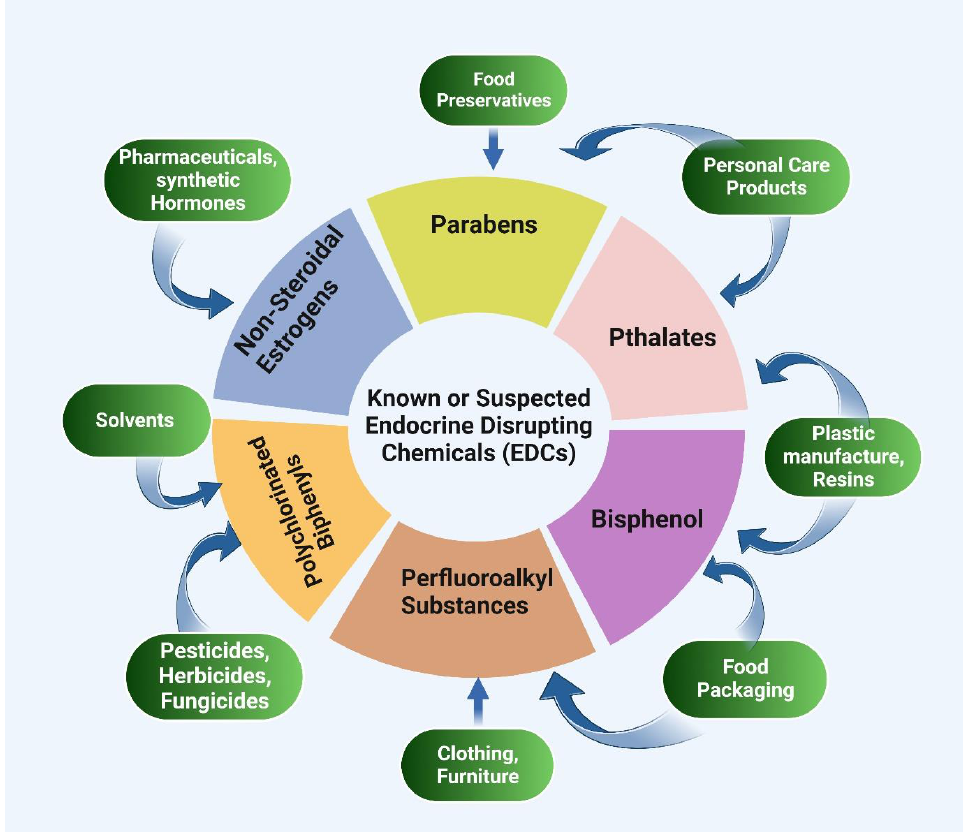
Figure 7. Most known EDCs and their sources. (Concept taken from [276] and created with BioRender.com. Last accessed 22 January 2023).